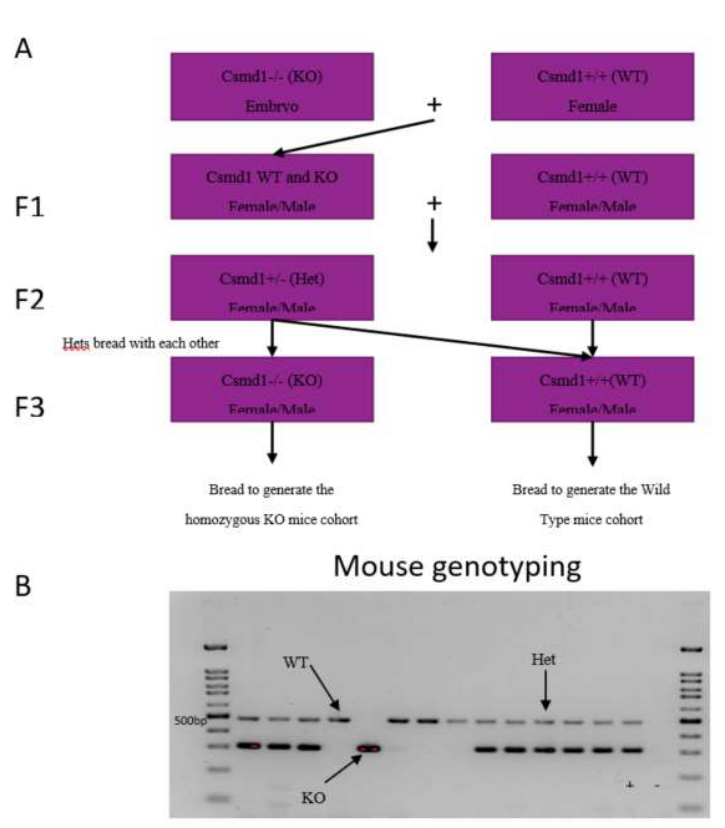
Figure A1. Information regarding the breeding structure used to generate the mouse cohort used in this study ( A ), along with a PCR gel electrophoresis image showing how the mice genotypes were identified ( B ). To generate the mouse the cohort initially a Csmd1 KO mouse embryos were implanted into a pregnant WT mouse, this generated the F1 generation consisting of both WT and KO mice. These mice were then breed with further WT mice (C57BL/6). This generated an F2 generation consisting of either heterozygotes (Hets) or WT mice. The Hets were then breed with each other to generate both KO and WT mice. The KO mice were then further breed with each other to obtain the full KO cohort, with mice being harvested at 4, 6, 8 and 12 weeks. The WT mice breed throughout this study were also harvested at the same time